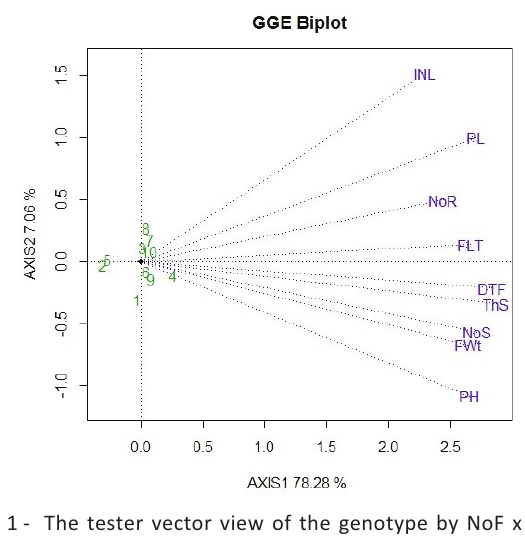
Fig. 1 ­ The tester vector view of the genotype by NoF x trait (GYT) biplot showing associations among the NoF x trait